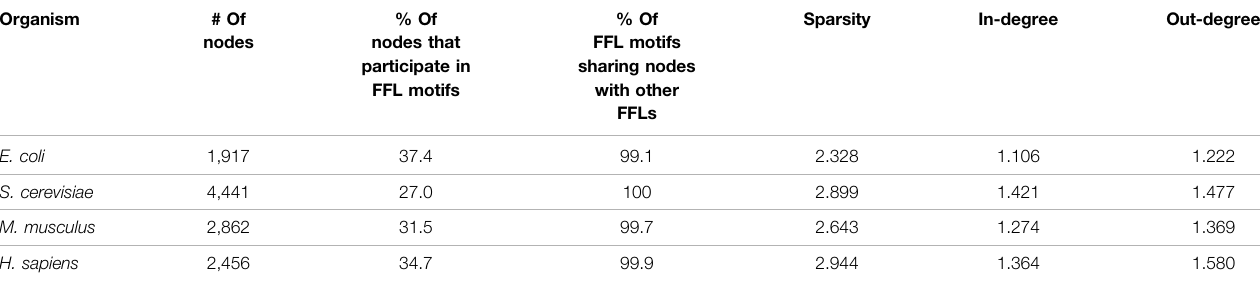
TABLE 1 | Biological GRNs ’ graph properties.